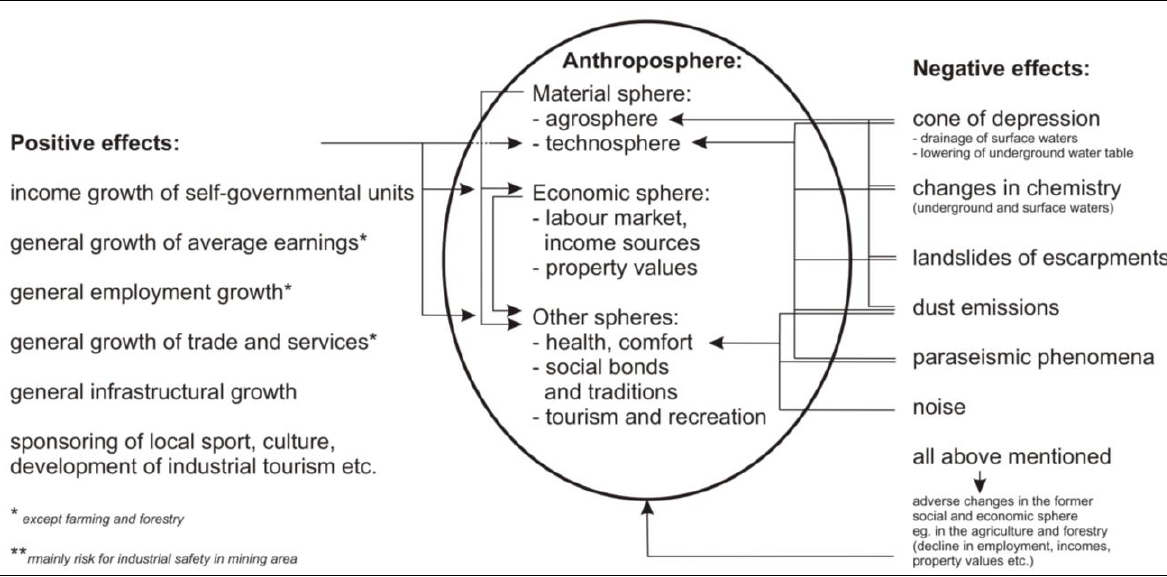
Fig. 2. Generalised model of existing and potential effects of surface lignite mining for the